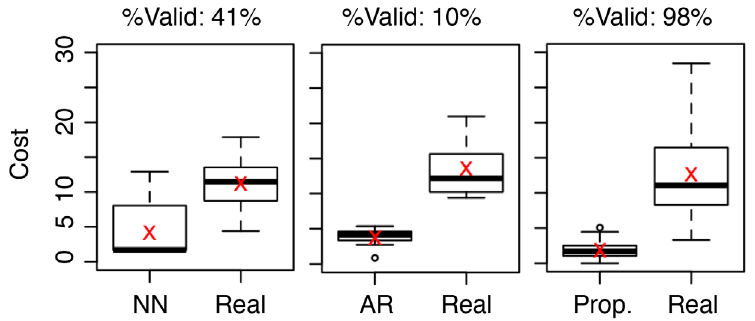
Fig 4. Cost distribution of valid answers using different methods. The cost distribution of each method is contrasted with that of the same set of samples in the real case. The mean values are marked using red